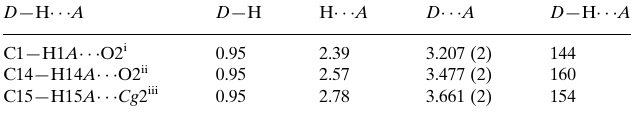
Hydrogen-bond geometry (A˚ , (cid:2) ). Cg 2 is the centroid of the C1–C6